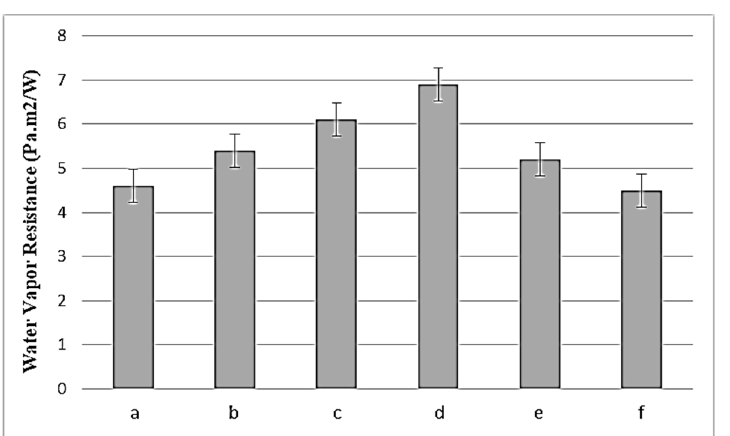
Figure 6. Water vapor resistance values for each specimen versus % content in CaCl 2 based on one-way ANONA ( p < 0.01). a: untreated; b: 10 wt % CaCl 2 ; c: 25 wt % CaCl 2 ; d: 50 wt % CaCl 2 ; e: 5 washes for b samples; f: 10 washes for b samples. The data are represented as mean ± SD.